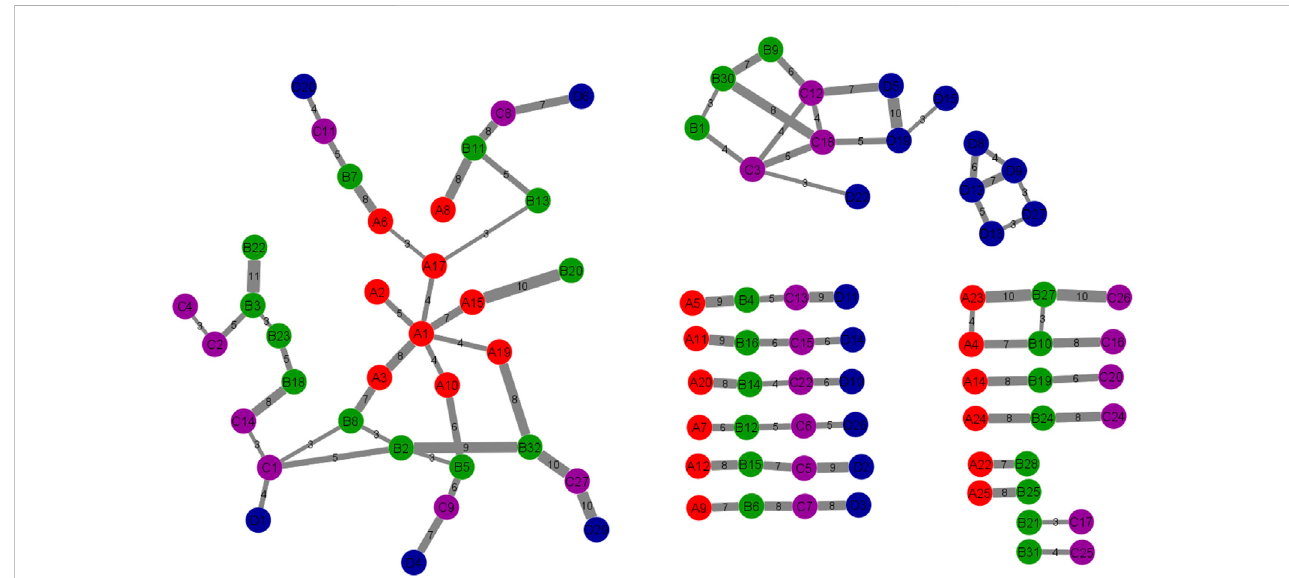
FIGURE 4 The Pathway Interaction Network. The correlation between 4 DE sets of pathways was obtained and expressed in this network. This network was constructed by combining the 7 cluster networks. Each node is a cluster of different stages which contained several numbers of genes and the edges represent the number of related genes. The thick edges were selected by overlapping genes counts between connected nodes. Red nodes or “ A ” : DE set I, green nodes or “ B ” : DE set II, purple nodes or “ C ” : DE set III, blue nodes or “ D ” : DE set